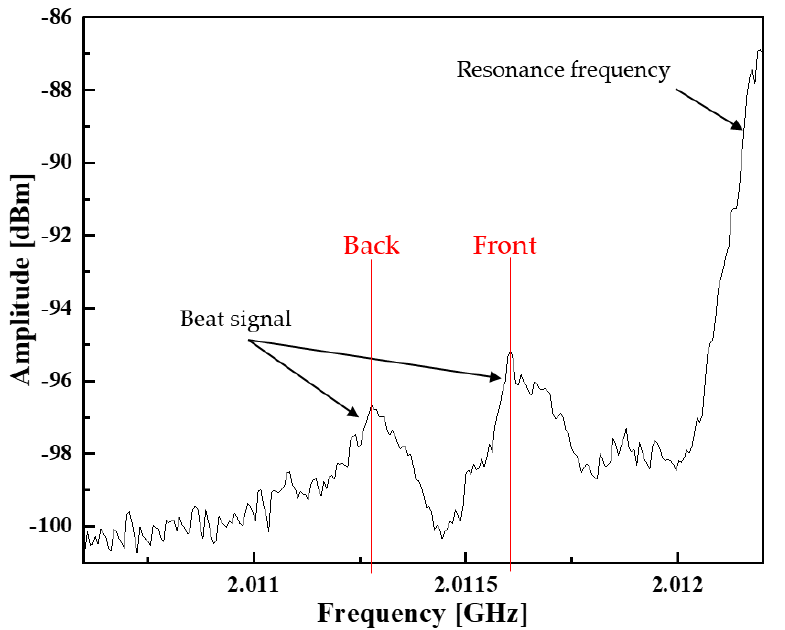
Figure 9. Beat signal spectrum generated by reflections from the front and back surfaces of the tile.